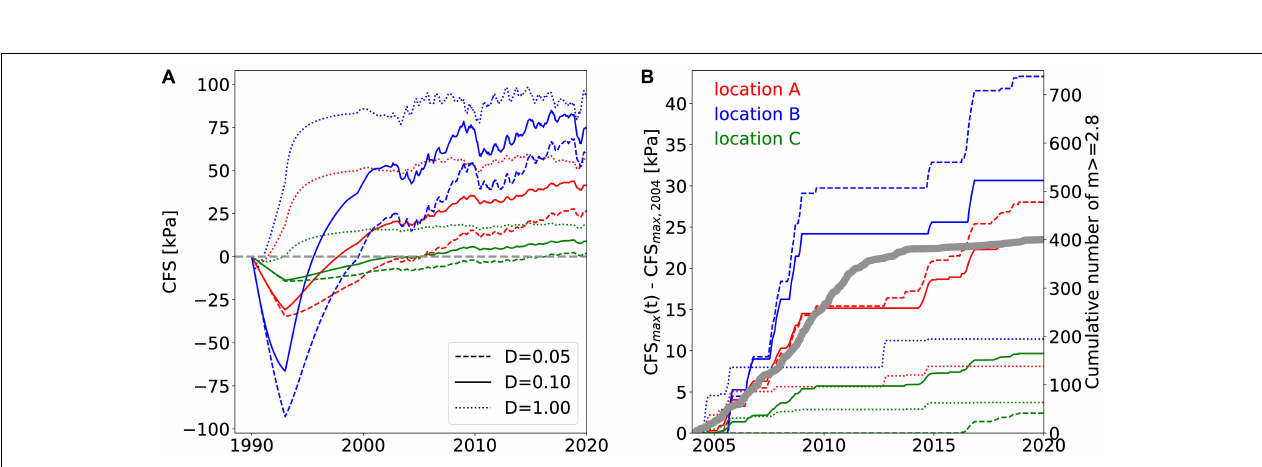
FIGURE 10 | (A) Time evolution of the total Coulomb stress calculated at the three locations indicated in Figure 9 at 5 km depth, assuming the mainshock mechanism as a receiver. The colors of the lines refer to the location, while the line style refers to different diffusivity values (see legend); (B) Temporal increase of the maximum CFS value relative to the year 2004 (for the same cases). Note that the number of triggered events should be proportional to these curves at the given location according to the simple CFS-model. For comparison, the cumulative events of the recorded M ≥ 2.8 background events in the whole area are shown by the bold gray line (with a scale on the